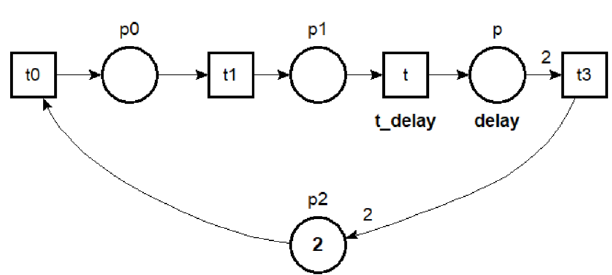
Figure 4. Augmented Petri net model associated with the SDF of Figure 2, using the reversibility rule established by Definition 1.